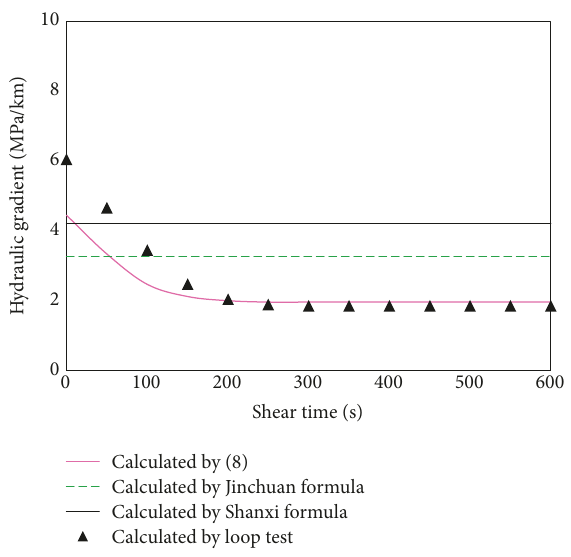
Figure 7: Comparison of calculated hydraulic gradient using different